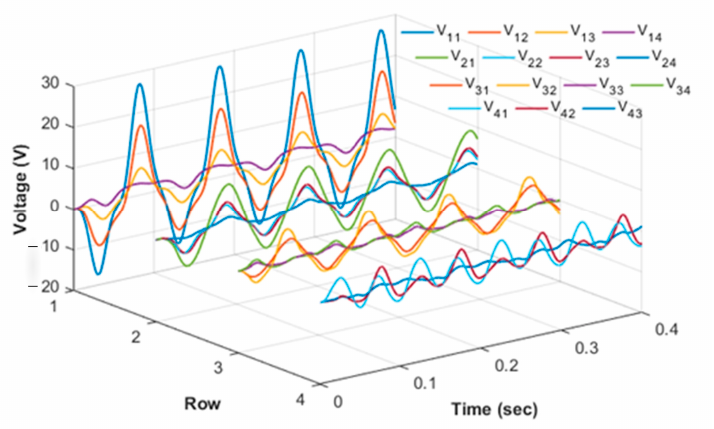
Figure 11. Output voltage waveforms for each row of grid blocks.